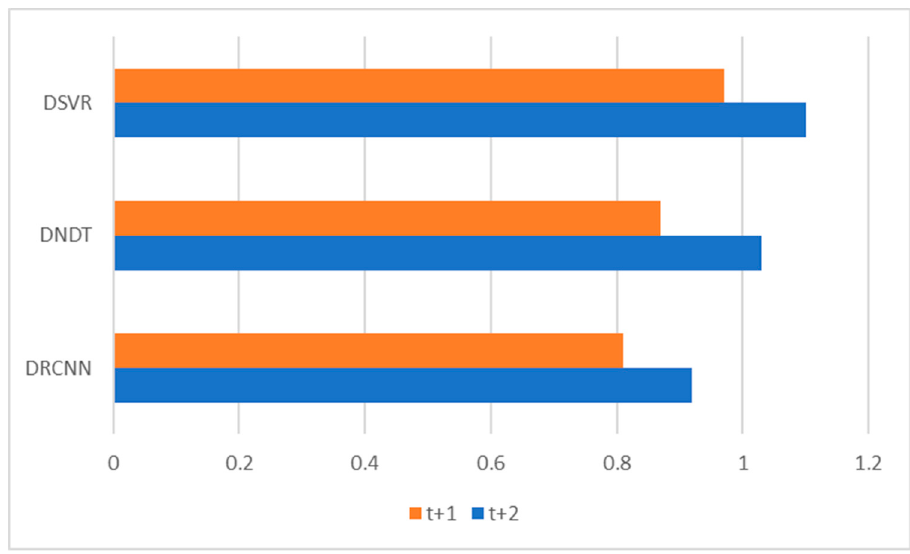
Figure 5. Multiple-step ahead forecasts in forecast horizon: RMSE.